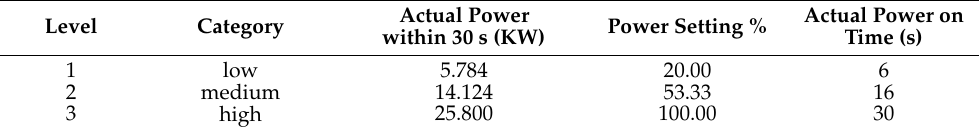
Table 3. Microwave power